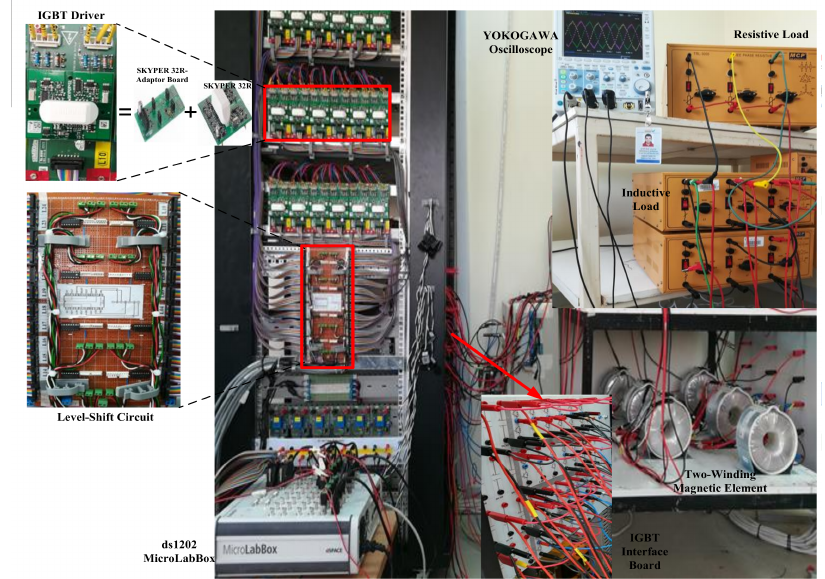
Figure 9. Prototype setup in the laboratory.